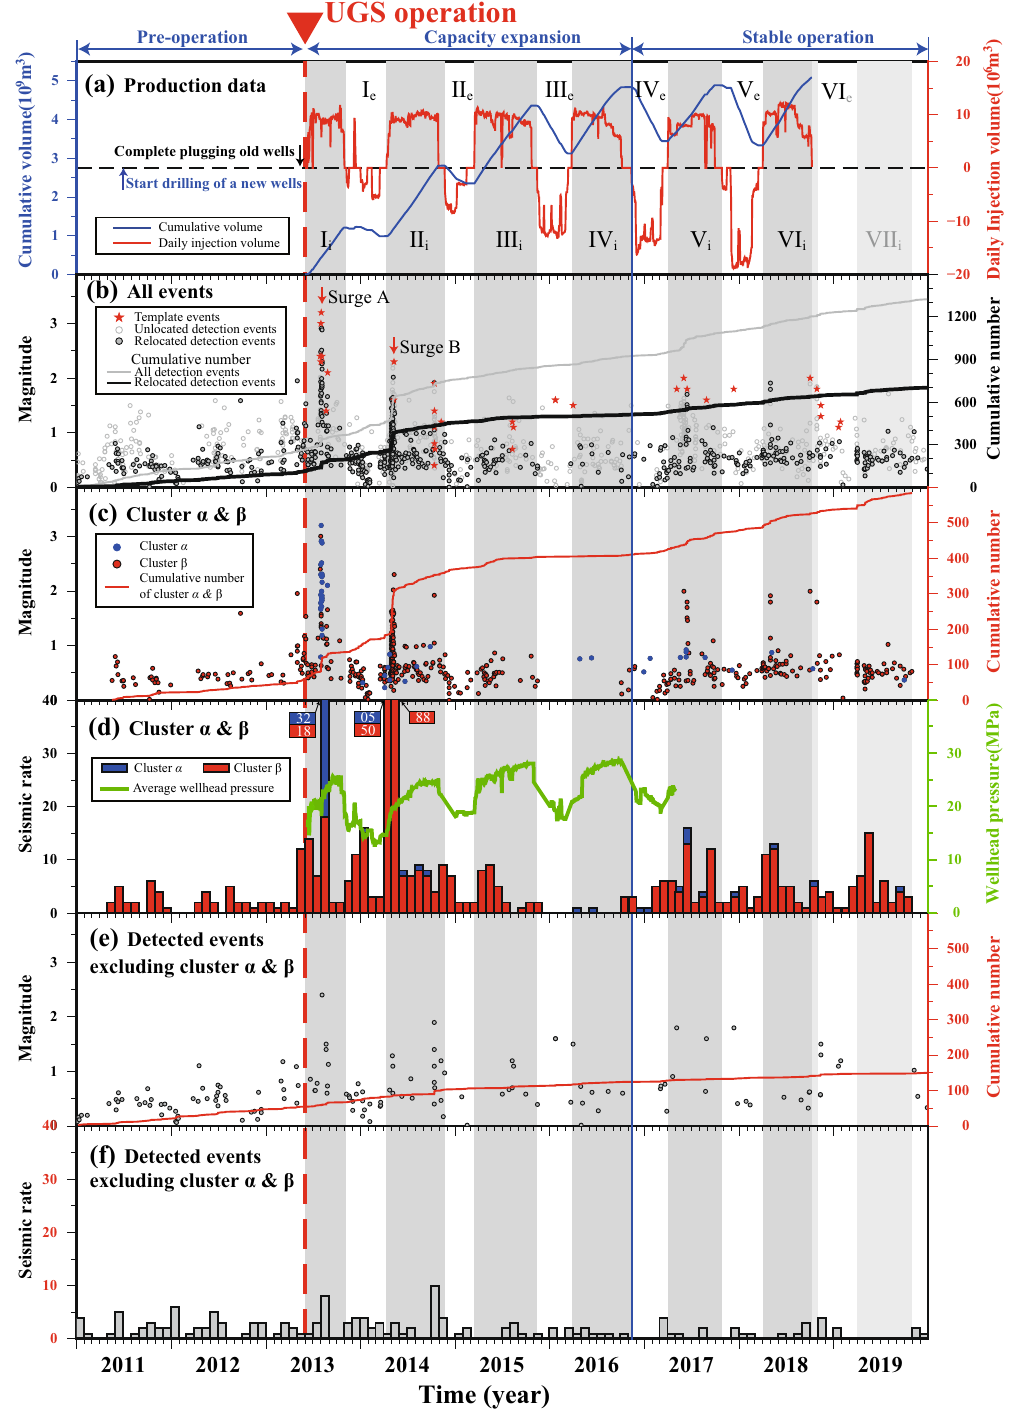
Figure 2. ( a ) The injection volume of the UGS during the study period. The red dashed line indicates the start of the Hutubi UGS operation (June 2013). The operation was divided into five complete cycles and half of a sixth cycle (I–V and VI i ) spanning the capacity expansion and stable operation stages. Each cycle includes two periods: the injection period (with subscript i, gray area) and extraction period (with subscript e, white area). ( b ) An M–t diagram of detected (gray dots) and relocated catalog (black dots) events. The cumulative number of the detected and relocated catalogs are represented by the black and gray lines, respectively. The red stars indicate the template events. An M–t diagram ( c ) and monthly seismic rates ( d ) for two clusters. The cumulative number and the average wellhead pressure are represented by the red ( c ) and green ( d ) lines, respectively. The M–t diagram ( e ) and monthly seismic rate ( f ) for the seismic events excluding the two clusters. The cumulative number is represented by the red